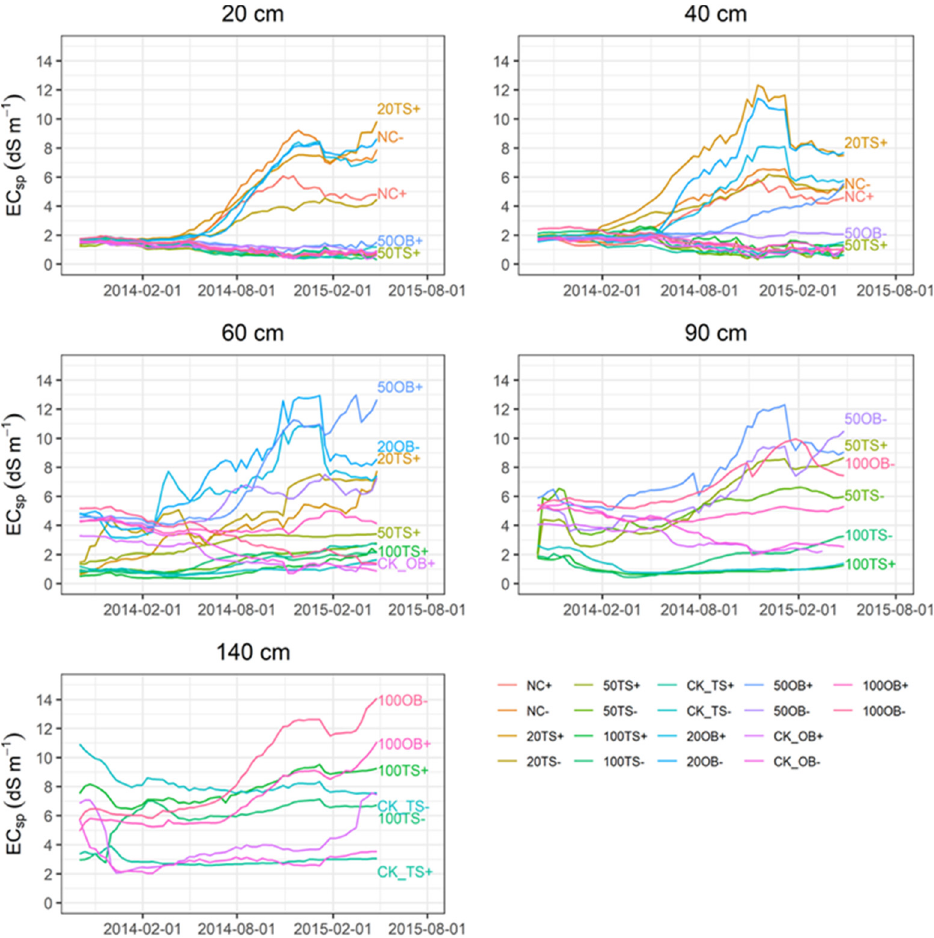
Figure 5. Temporal variations of soil EC sp in the cover soils and barrier layers monitored by the probes.